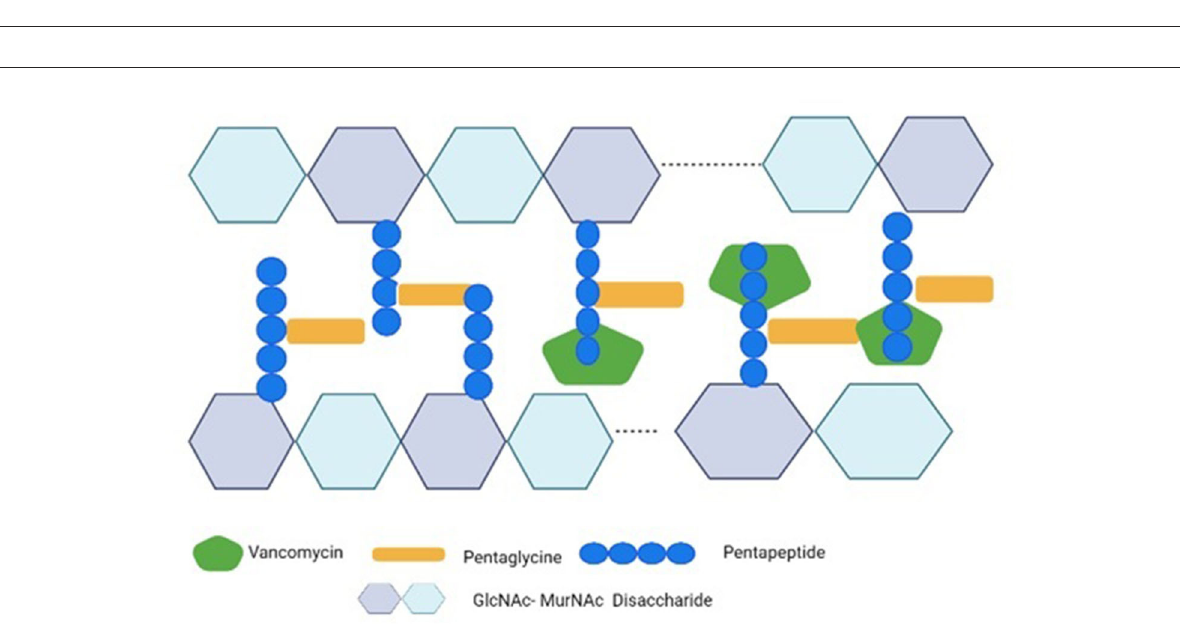
FIGURE2 Vancomycin’s mechanism of action against S. aureus. Vancomycin inhibits the cross-bridge formation between pentagen and pentaglycine by binding to the D-Ala-D-Ala residues of pentapeptide’s C-terminal D-Ala-D-Ala. The GlcNAc stands for N-acetylglucosamine; the MurNAc stands for N-acetylmuramic